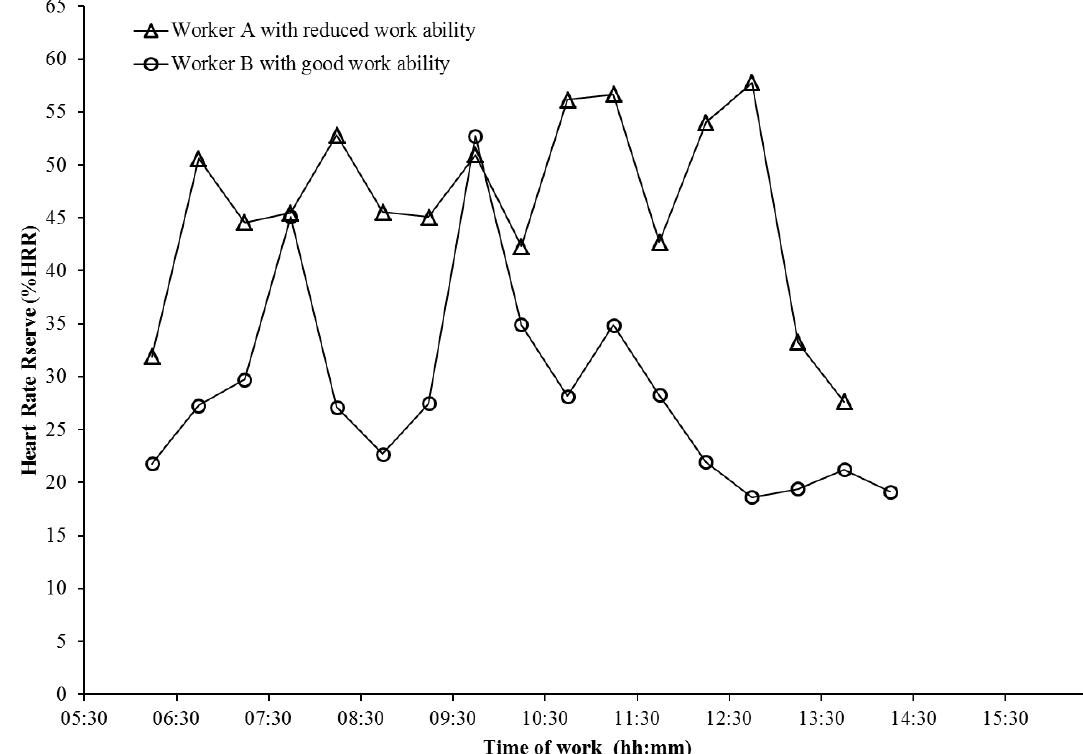
Figure 2. Exemplary visual representation of the heart rate reserve (%HRR) for two workers from the same workplace with similar work hours, but different work ability (male worker A with reduced work ability and male worker B with good work